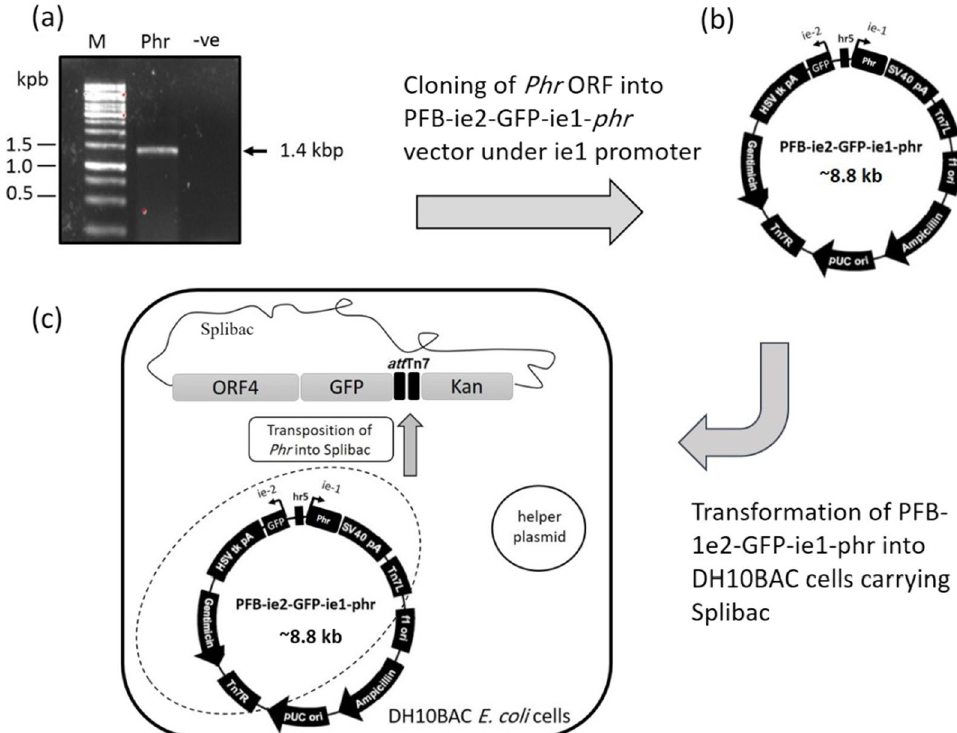
Fig. 1 Schematic representation shows construction of the recombinant vSpli-phr harboring the phr gene ORF. a A total of 1% agarose gel shows the amplified photolyase gene ORF ( phr ) of 1.4 kpb. Lane ( ve): PCR negative control. M: 1 kb ladder. b Plasmid map shows the phr gene that was − cloned downstream from the ie-1 promoter of the modified pFastBac-Dual vector generating the hybrid plasmid PFB-ie2-GFP-ie1-phr of about